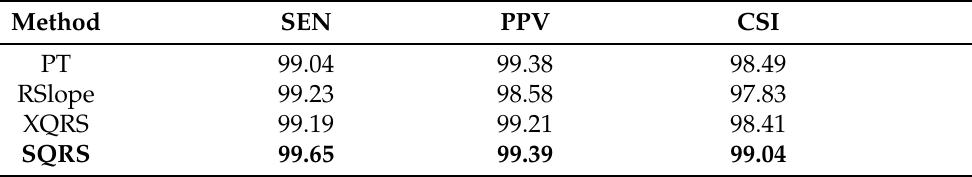
Table 2. Comparison of R-peak detection performance with some classic methods. Method